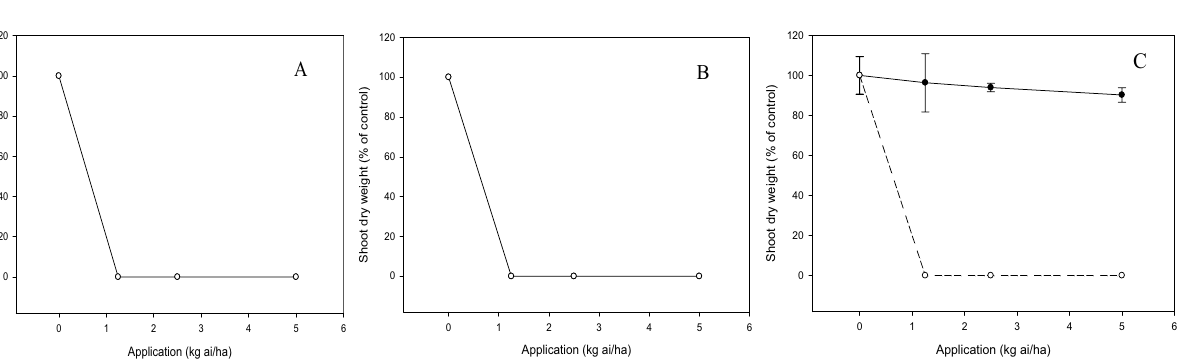
Figure 4. Herbicidal effects of c (solid line) and diuron (dashed line) treatments on shoot dry weight of Eleusine indica ( A ), Oldenlandia verticillata ( B ) and Cyperus iria ( C ) respectively 3 weeks after post-emergence application.